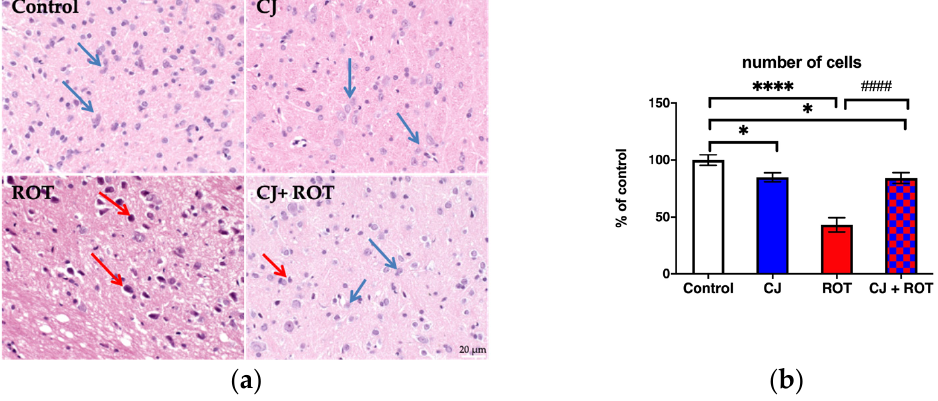
Figure 4. Representative photomicrographs of rat midbrain sections stained with hematoxylin and eosin (H&E). Normal neurons (blue arrows) are seen in Control and CJ alone treated rats. ROT administration caused noticeable degeneration of neurons (red arrows). Rats treated with CJ + ROT exhibit normal neurons (blue arrows) with a few cells with signs of degeneration (red arrows). Scale bar—20 μ m ( a ); Quantification of cells on two sections from 3 animals from each group expressed as a percent of control ( b ). Data were analyzed using one-way ANOVA followed by Fischer’s LSD multiple comparisons test. * p < 0.05 vs. control; **** p < 0.0001 vs. control; #### p < 0.0001 vs. ROT ( b ).